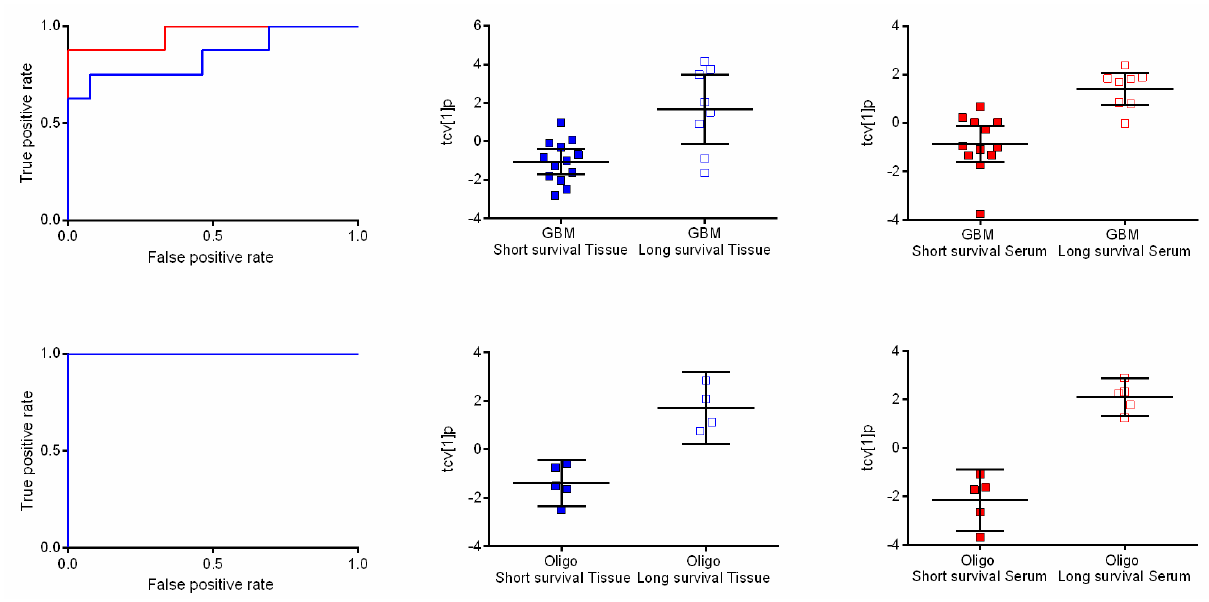
Figure 2. Receiver operating characteristic (ROC) curves and scatter plots of orthogonal partial least squares-discriminant analysis (OPLS-DA) scores following a seven-fold cross-validation procedure showing differences between long and short survival time. ( Upper panel ) ROC curves based on the cross-validated score values from the final OPLS-DA model for the discrimination of short survival time compared to long survival time in patients with glioblastomas in tissue (blue line) and serum (red line) with ROC values of 0.846 (0.647–1.000) and 0.958 (0.870–1.000), respectively (left) . The scatter plots show class differences between short survival time and long survival time based on cross-validated predictive OPLS-DA scores (tcv[1]p) for tissue ( center ) and serum ( right ). ( Lower panel ) ROC curves based on the cross-validated score values from the final OPLS-DA model for the discrimination of short survival time compared to long survival time in patients with oligodendrogliomas in tissue (blue line) and serum (red line). AUROCC values for survival in oligodendroglioma were calculated to 1 (1.000–1.000) for both tissue and serum (left) . The scatter plots show class differences between short survival time and long survival time based on cross-validated predictive OPLS-DA scores (tcv[1]p) for tissue ( center ) and serum ( right